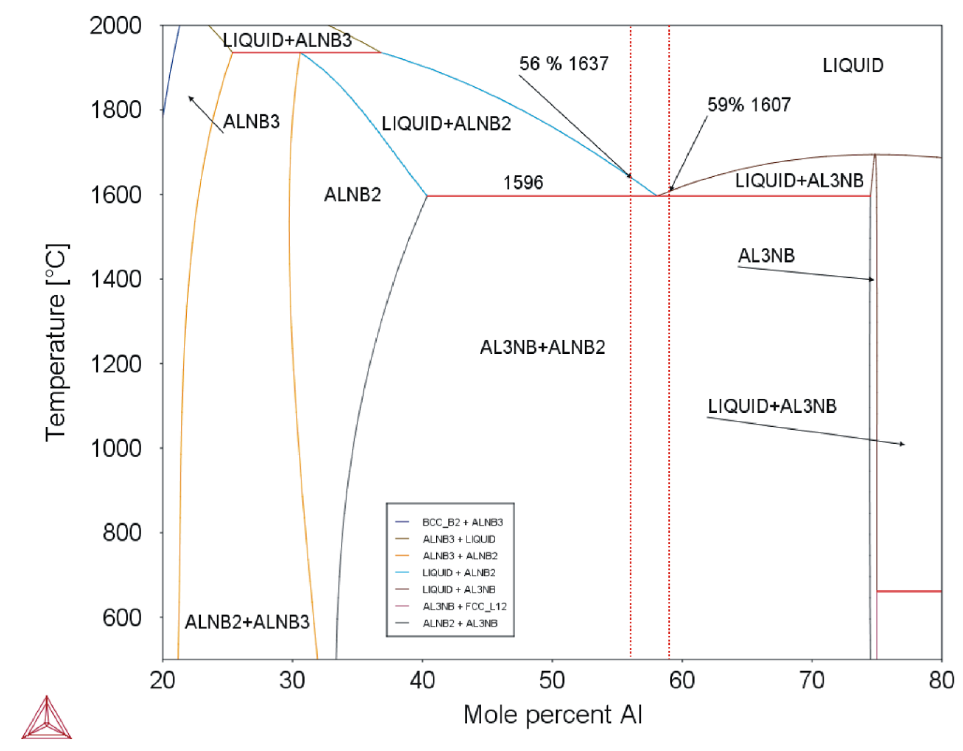
Figure 11. Binary diagram of Nb – Al system (Thermo-Calc; dotted red lines mark composition of analysed alloys). Table 3. Measured values of liquidus and solidus in Nb – Al-VIM-1 and Nb – Al-PAM-1 samples by